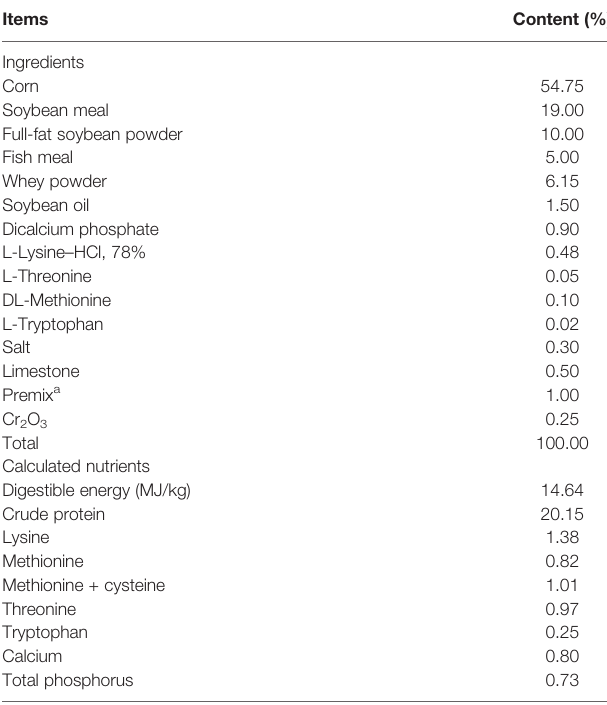
TABLE 1 | Composition and nutrient levels of the experimental diet (%, as-fed basis). Items